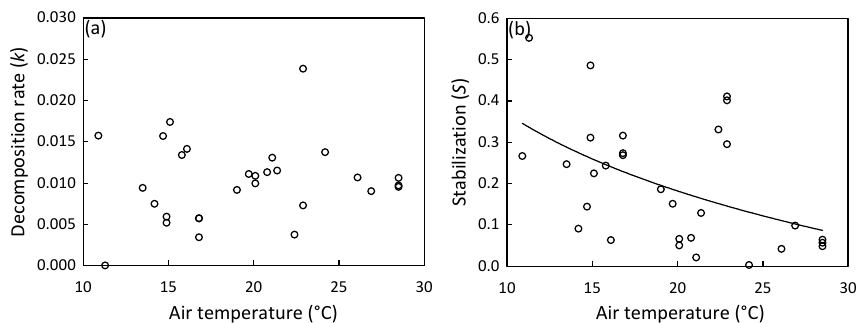
Figure 2. Site means of decomposition rate (a) and stabilization (b) versus mean air temperature during deployment period. Regression line illustrates the significant relationship between temperature and stabilization (Table 2); the regression model with the lowest standard error of estimate (SEE) and highest R 2 is shown: y = − 0 . 27ln (x) + 0 . 99; R 2 = 0 . 239; SEE = 0.131. Excluding Mediterranean sites (21.9–23.6 ◦ C; n = 4) from the regression yields the following: y = − 0 . 344ln (x) + 1 . 233; R 2 = 0 . 510; SEE =